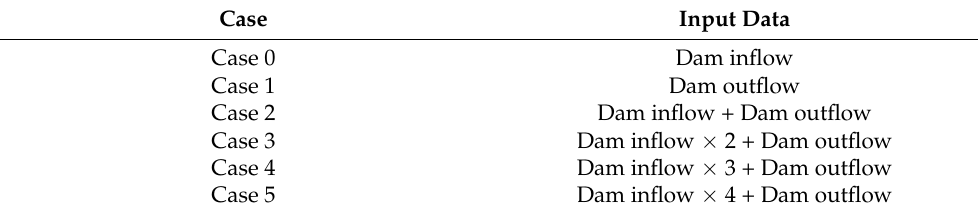
Figure 11. Watershed layout for analysis of the impact of dam on drought propagation characteristics. Table 7. Propagation probability of hydrological drought under various seventies of meteorological drought at Hapcheon Dam